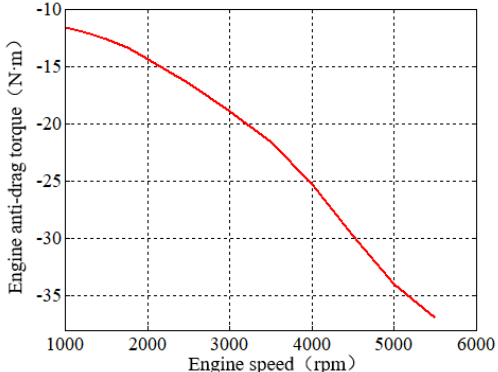
Figure 4. Engine speed and anti-drag torque diagram.